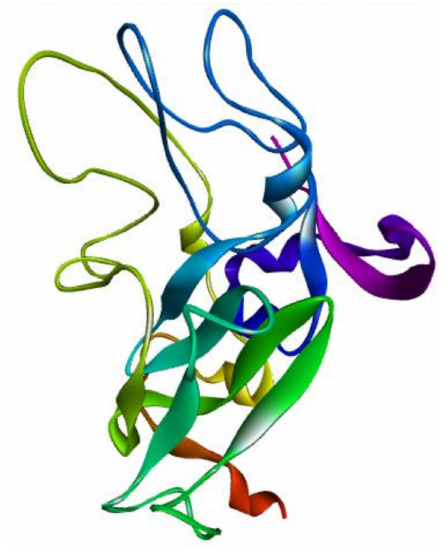
Figure 4. Model of the E2 protein of